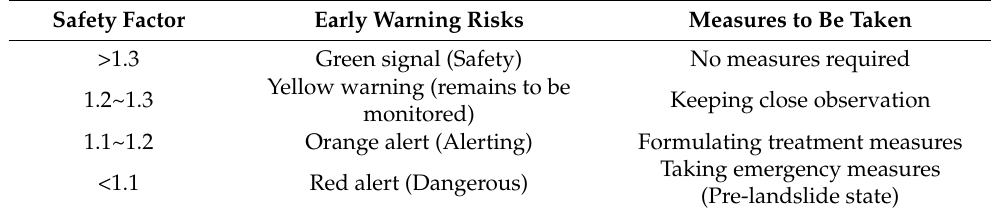
Table 6. Early warning hierarchy of landslide